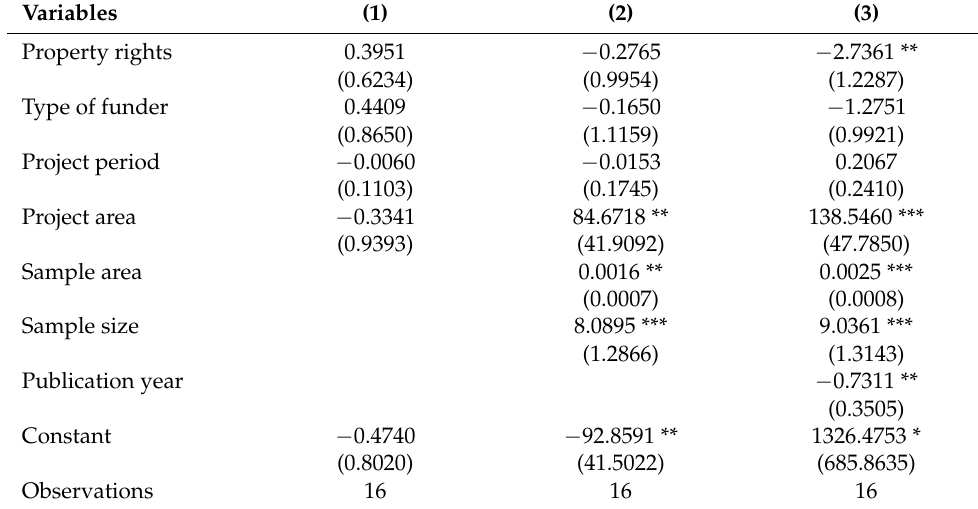
Table 5. The results of PES for poverty